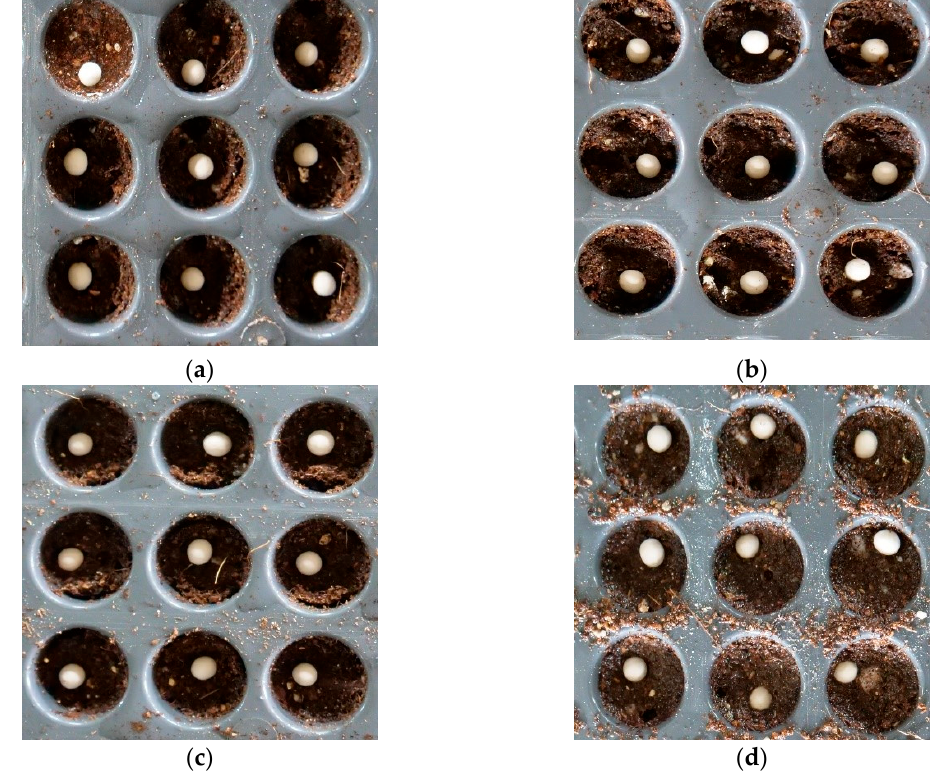
Figure 12. Seed and bed soil conditions after irrigation: ( a ) Case 1; ( b ) Case 2; ( c ) Case 3; ( d ) Case 4.